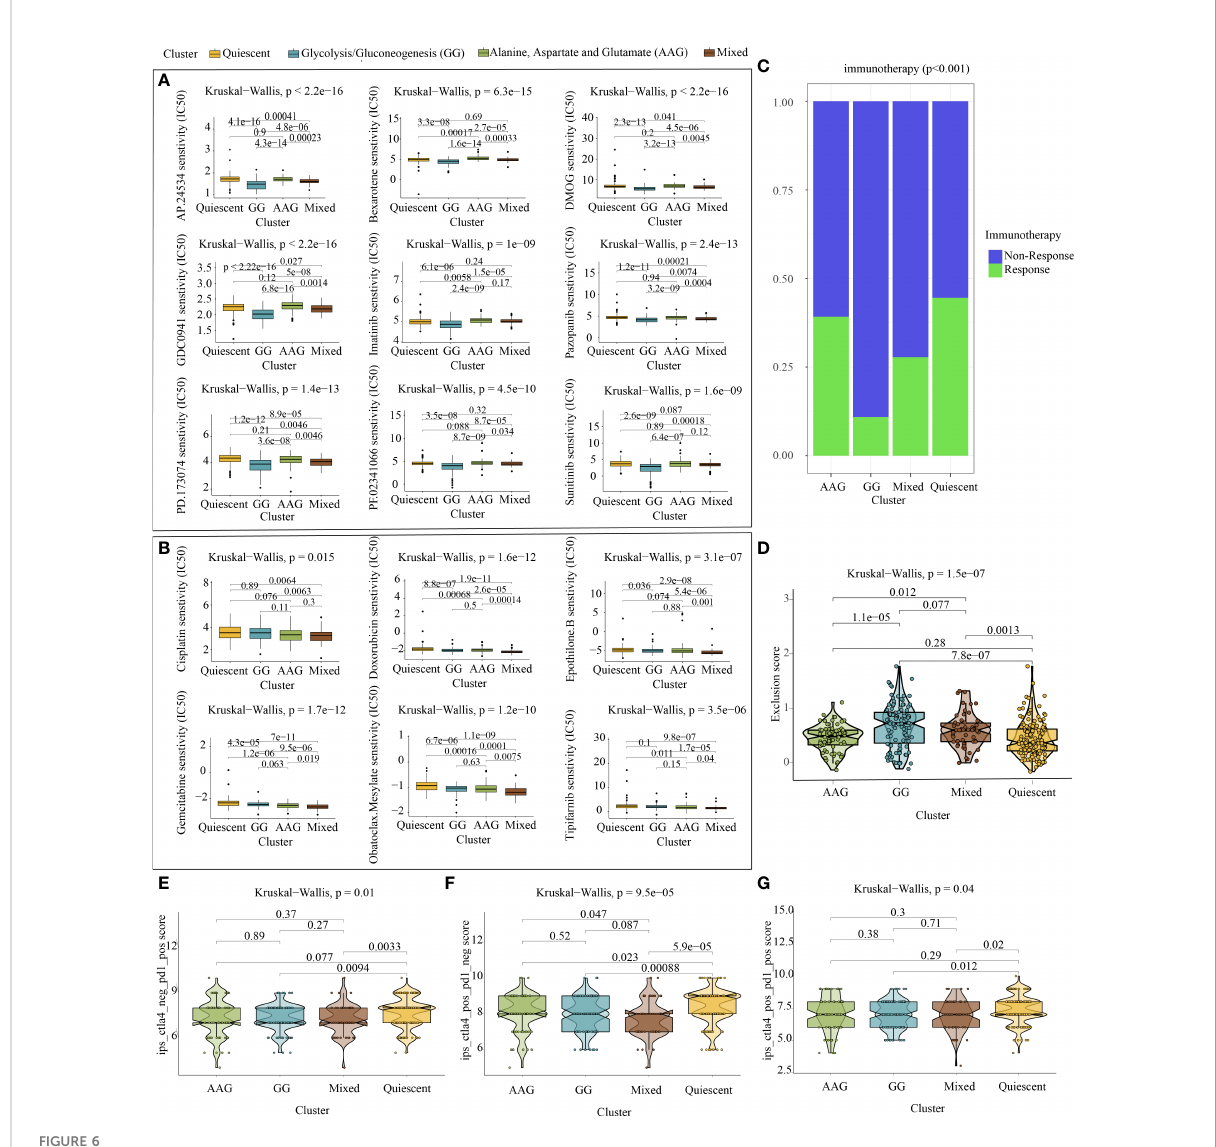
FIGURE 6 Chemotherapy prediction and immunotherapy response evaluation. (A) Identi fi cation of nine targeted drugs bene fi cial for the glycolysis/ gluconeogenesis subtype. (B) Identi fi cation of six targeted drugs bene fi cial for the mixed subtype. (C) Prediction of immunotherapy outcomes of each metabolic subtype using the ImmuneCellAI algorithm. (D) Violin plot demonstrating the immune escape capacity of each metabolic subtype evaluated using the TIDE platform. (E) Distribution of IPS for PD1/PDL1/PDL2 inhibitors. (F) Distribution of IPS for CTLA4 inhibitors. (G) Distribution of IPS for CTLA4 and PD1/PDL1/PDL2